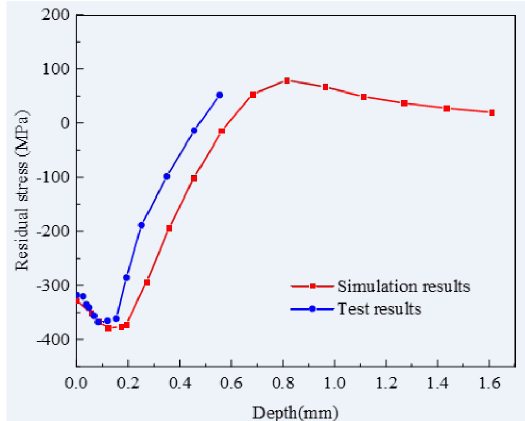
Figure 6. Distribution of residual stress on the specimen surface with depth.